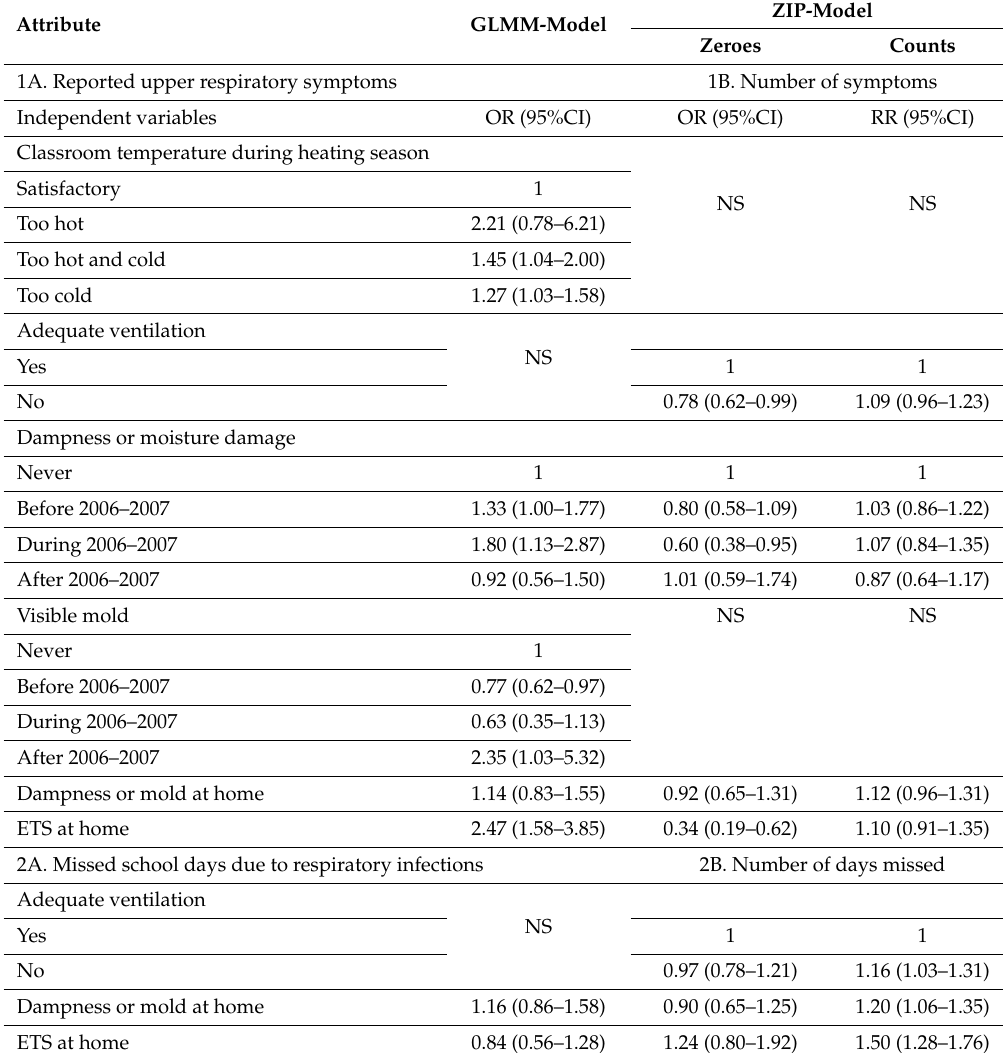
Table 3. Fitted models predicting (1) upper respiratory symptoms and (2) missed school days due to respiratory infections. Variables not selected (NS) did not significantly improve the